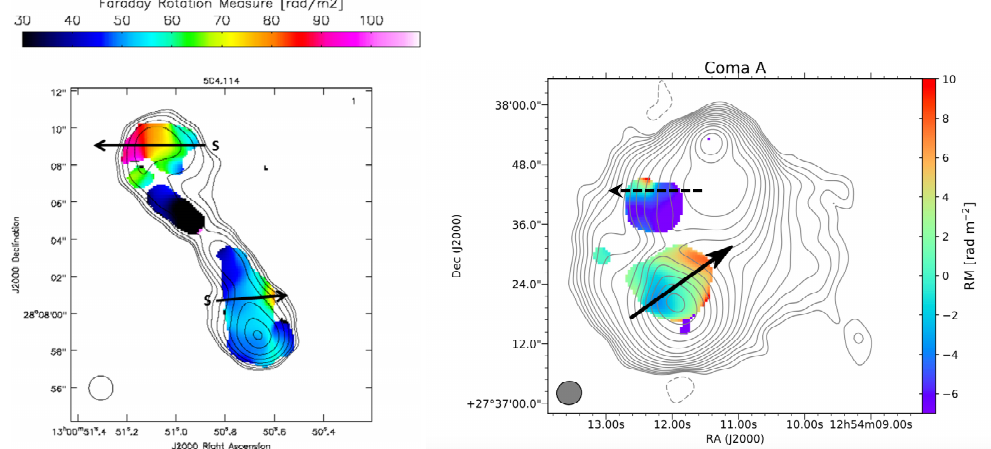
Figure 6. Transverse RM gradients across the two jets of the radio galaxies 5C4.114 ( left , adapted from [43]) and Coma A ( right , adapted with permission from [27]), showing the pattern expected for winding up an initially dipolar B field (upper part of Figure 5). The black arrows across the two jets highlight the directions for the corresponding transverse RM gradients. Both transverse RM gradients in 5C4.114 and the southern transverse RM gradient in Coma A have significances exceeding 3 σ ; the significance of the northern gradient in Coma A is less than 3 σ , and must be considered tentative. The sizes of the Gaussian restoring beams are shown by the ellipses in the bottom left-hand corners of the